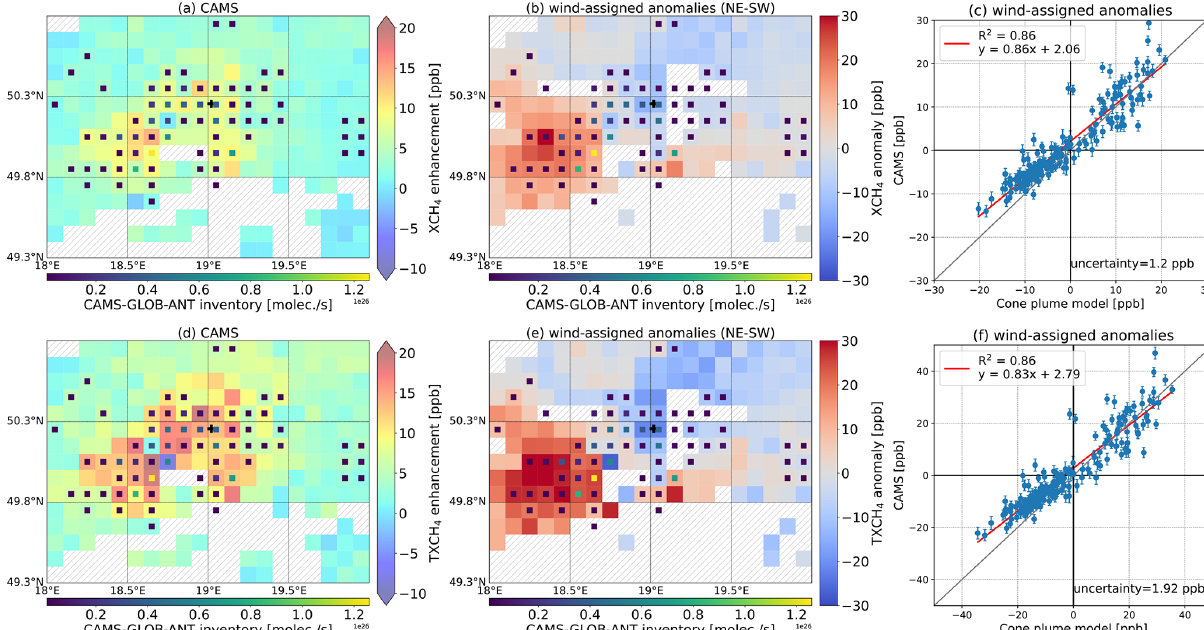
Figure A4. Similar to Fig. 5 but using ERA5 wind at